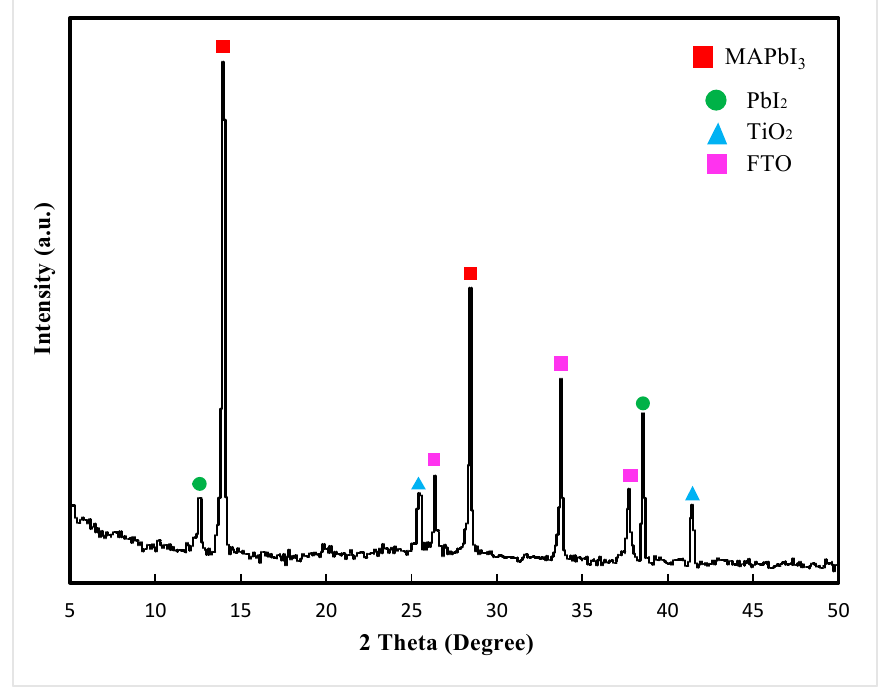
Figure 5. XRD pattern of perovskite light-absorbing layer film.